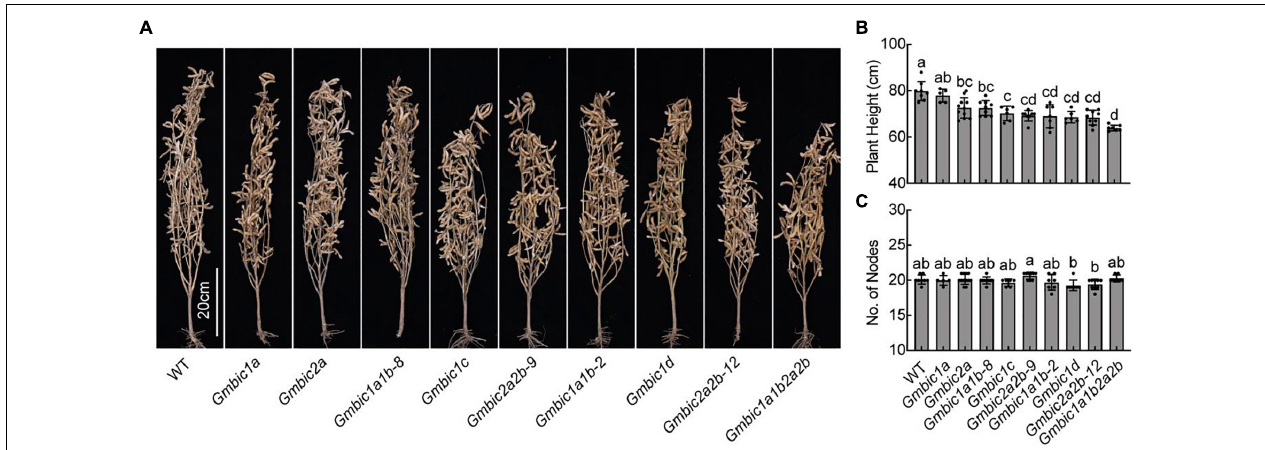
FIGURE 4 | Plant height phenotypes of Gmbic mutants in field. (A) Representative images of indicated lines at the maturation stage grown in the Beijing field in 2021. Homozygous CRISPR/Cas9 knockout lines at T4 or higher generation were used. Scale bars = 20 cm. Statistical analysis of the plant height (B) and the number of nodes (C) of each line in (A) . Data are means ± SD ( n > 5). Lowercase letters indicate significant differences ( p < 0.05, one-way ANOVA with Tukey’s multiple comparisons test).